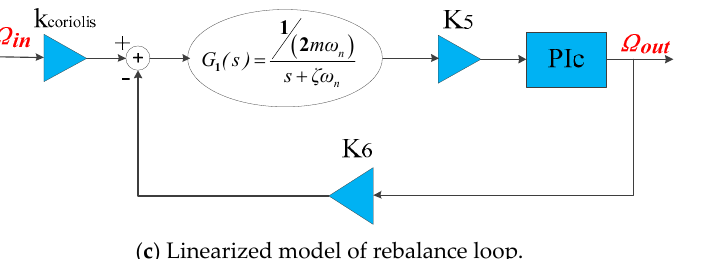
Figure 18. Linearization process of the rebalance loop.